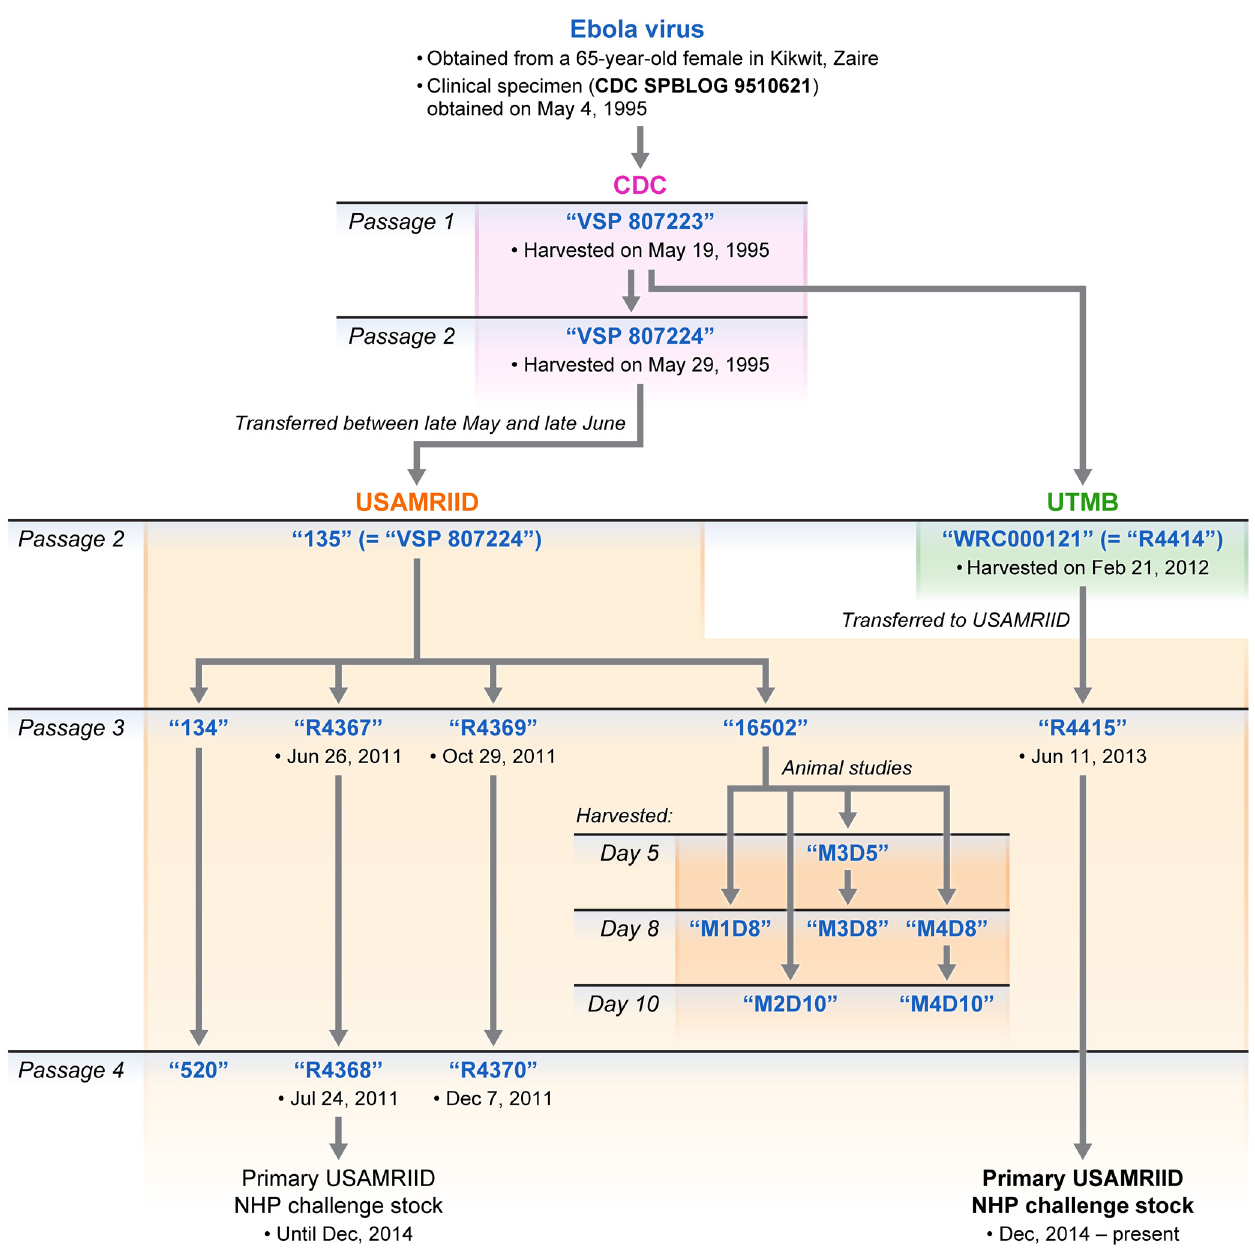
Fig 1. History of Ebola virus variant Kikwit (isolate 9510621) challenge stocks used at the United States Army Medical Research Institute of Infectious Diseases (USAMRIID), CDC, Centers for Disease Control and Prevention; NHP, nonhuman primate; SPBLOG, Special Pathogens Branch Log; UTMB, University of Texas Medical Branch; VSP, virus seed